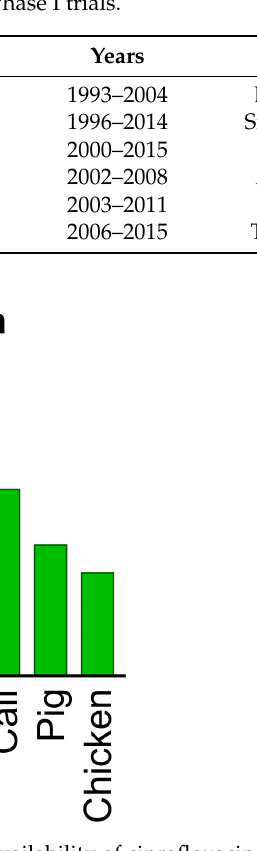
Figure 2. Inter-species differences in oral bioavailability of ciprofloxacin. Data are obtained from the PACT-F database which contains drug structures and detailed pharmacokinetic results from more than 25,000 trials. Pronounced inter-species differences are also found for many “blockbuster drugs” Adapted from [110], Blockbuster Drugs